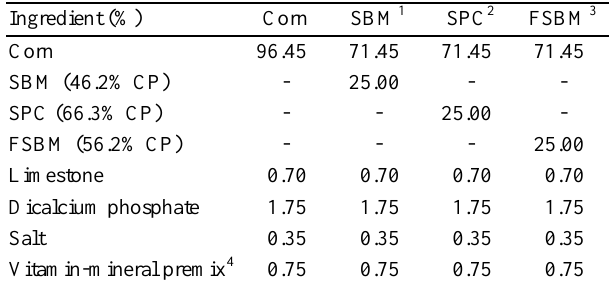
Table 2. Ingredient composition of experimental diets containing soybean meal (SBM), soy protein concentrate (SPC) and fermented soybean meal (FSBM) (as-fed basis), Exp. 1